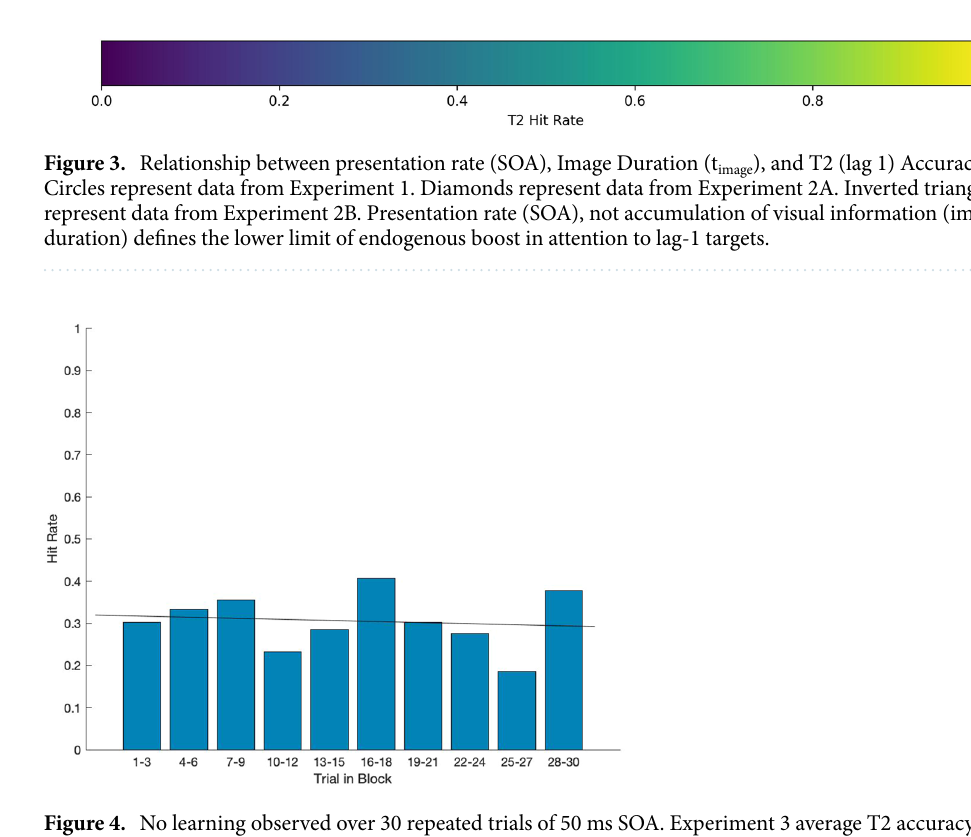
Figure 4. No learning observed over 30 repeated trials of 50 ms SOA. Experiment 3 average T2 accuracy (y-axis) across a bin of 3 consecutive trials (x-axis). A total of 10 bins are shown, representing results from all trials (1–30) of experiment 3 (N = 18 subjects). Best fit line (black) from least squares regression of target hit rates over the 30-trial block. Experiment 3 trials were identical to Experiment 1 in structure (SOA = t image , t fill = 0 ms). At a below threshold range SOA, subjects are not able to perform with high accuracy, likely due to insufficient time to engage lag-1